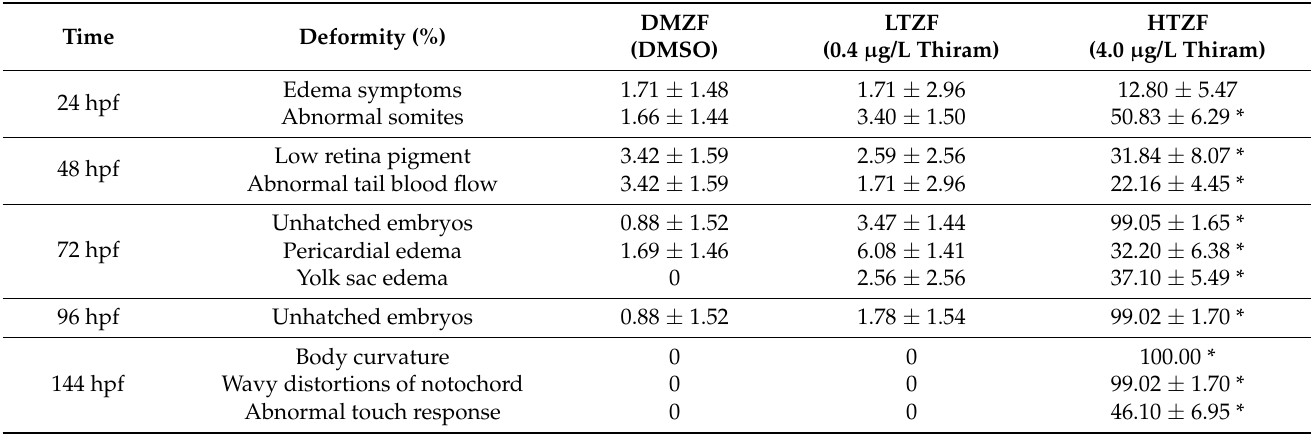
Table 1. Proportions of developmental deformities scored after 24, 48, 72, 96, and 144 h of thiram exposure.